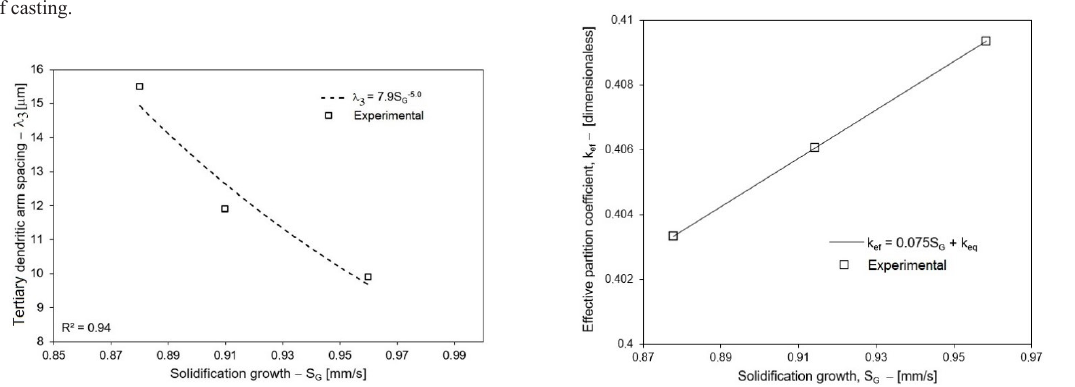
Figure 8. Tertiary dendritic arm spacing (λ growth ( S ). G